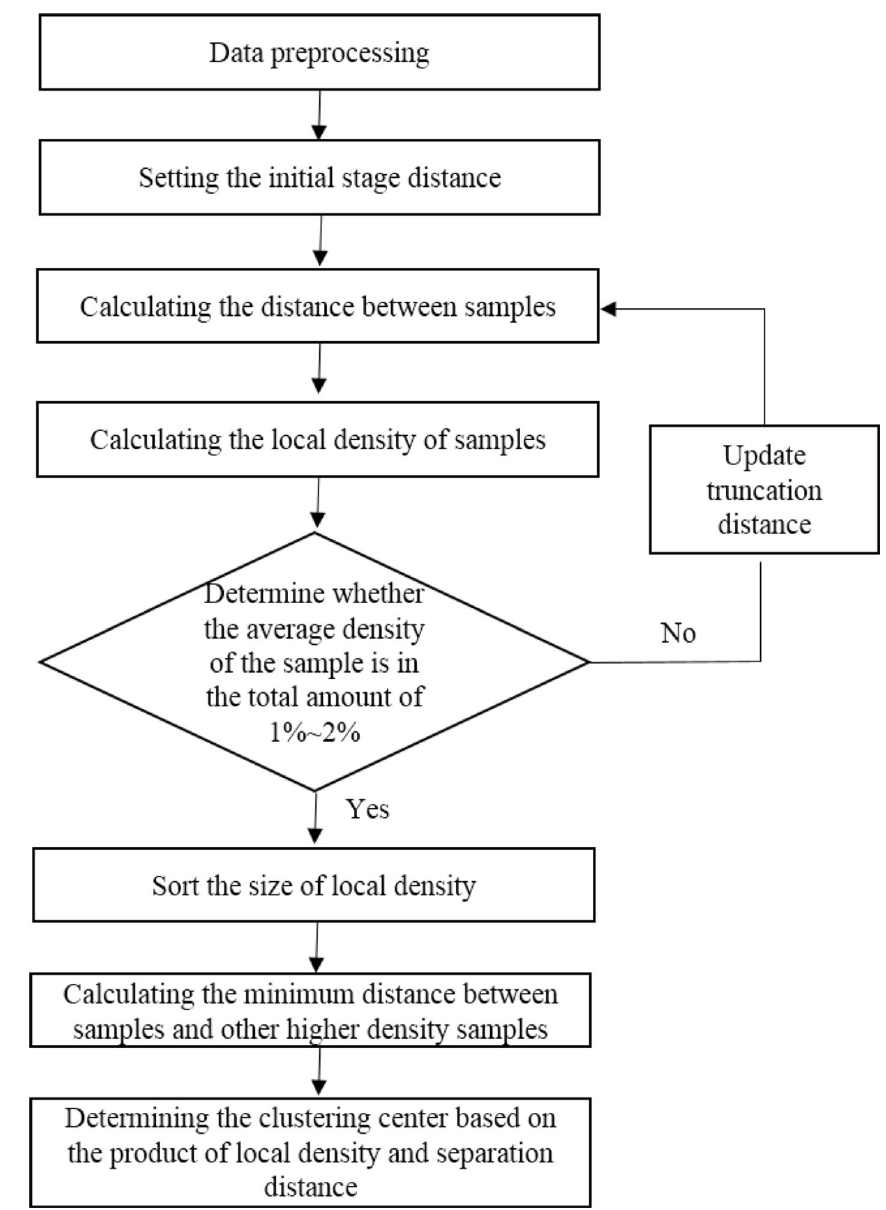
Fig. 1 Calculation flow chart of peak density